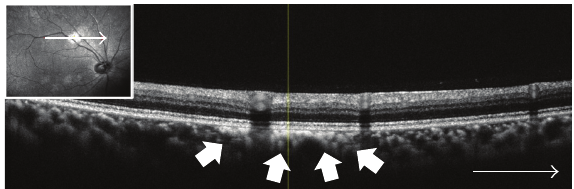
Figure 3: Right optical coherence tomography image. Note the irregular hyperreflectance focus in the choroid